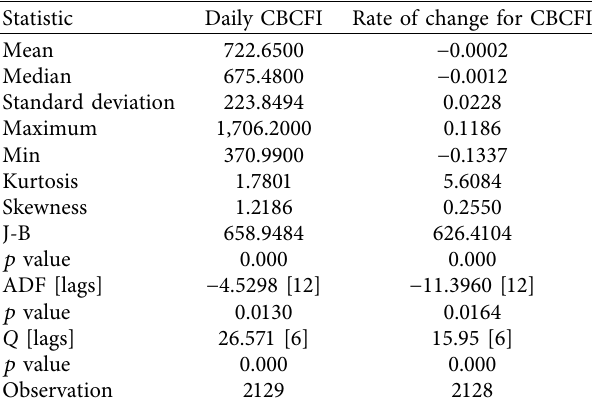
Figure 2: Tendency of daily CBCFI dataset adopted for predicting Table 1: Descriptive statistics of daily CBCFI and rate of change of CBCFI.